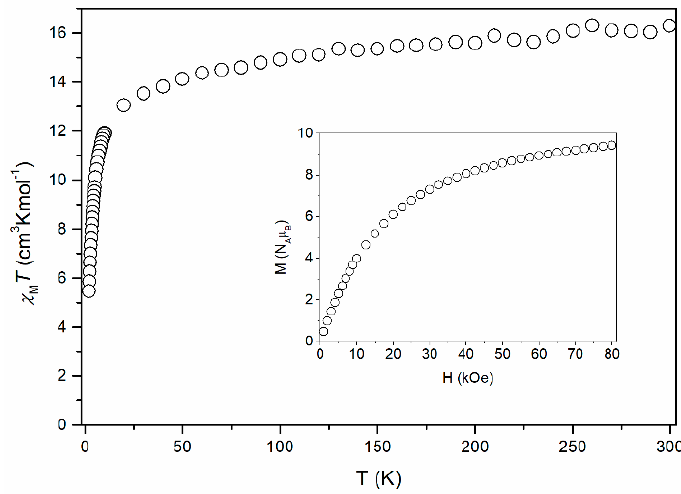
Figure 9. Plots of χ M T vs. T at 1000 Oe and M vs. H at 2 K (inset) for 2 .